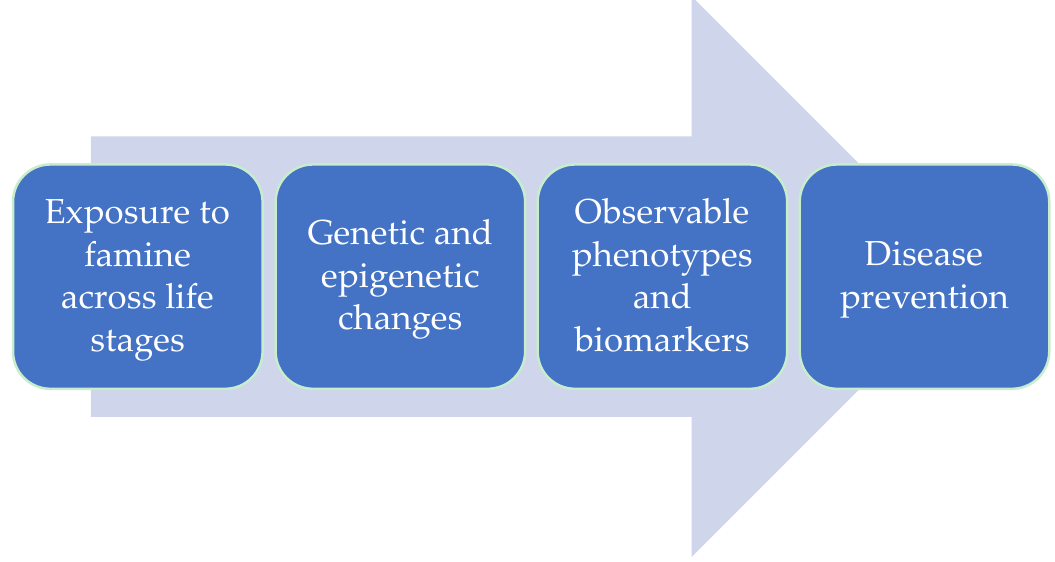
Figure 2. Translating epigenetic markers of famine exposure to public health interventions. ( a ) Environmental exposures throughout life induce epigenetic and genetic alterations, particularly in susceptible populations. ( b ) Epigenetic and genetic changes serve as molecular biosensors of environmental exposure effects, and these effects can be quantified within populations. ( c ) Epigenetic and genetic changes could presage observable phenotypes, including both disease phenotypes and biomarkers, indicative of disease. ( d ) At-risk individuals and subpopulations identified by molecular sensors and biomarkers can be targeted for public health intervention [11].